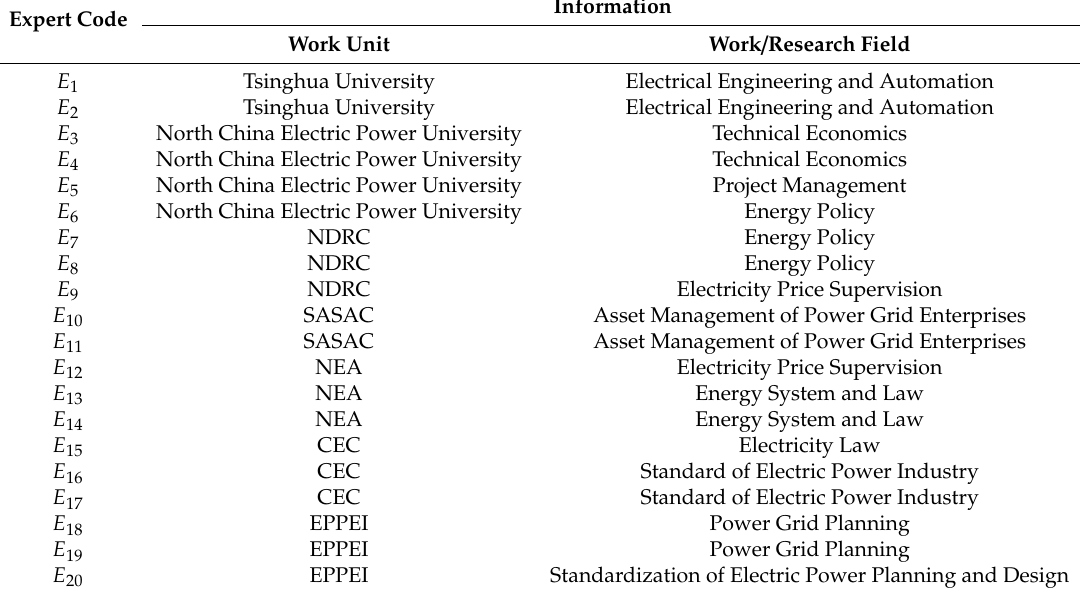
Table A2. Expert information. NDRC—National Development and Reform Commission; SASAC— State-Owned Assets Supervision and Administration Management Commission of the State Council; NEA—National Energy Administration; CEC—China Electricity Council; EPPEI—China Electric Power Planning and Engineering Institute.